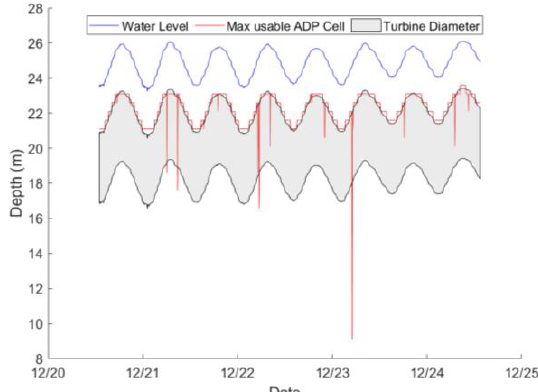
Fig. 2. Sample period showing water depth (blue line), area of water column occupied by turbine (grey area) and the maximum usable ADP cell (red line).